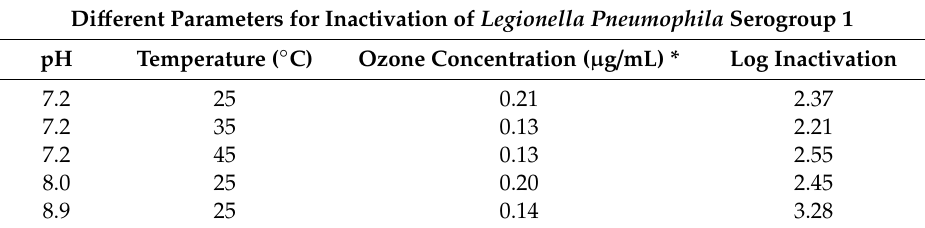
Table 4. Ozone inactivation of L. pneumophila serogroup 1 at di ff erent parameters. Adapted from